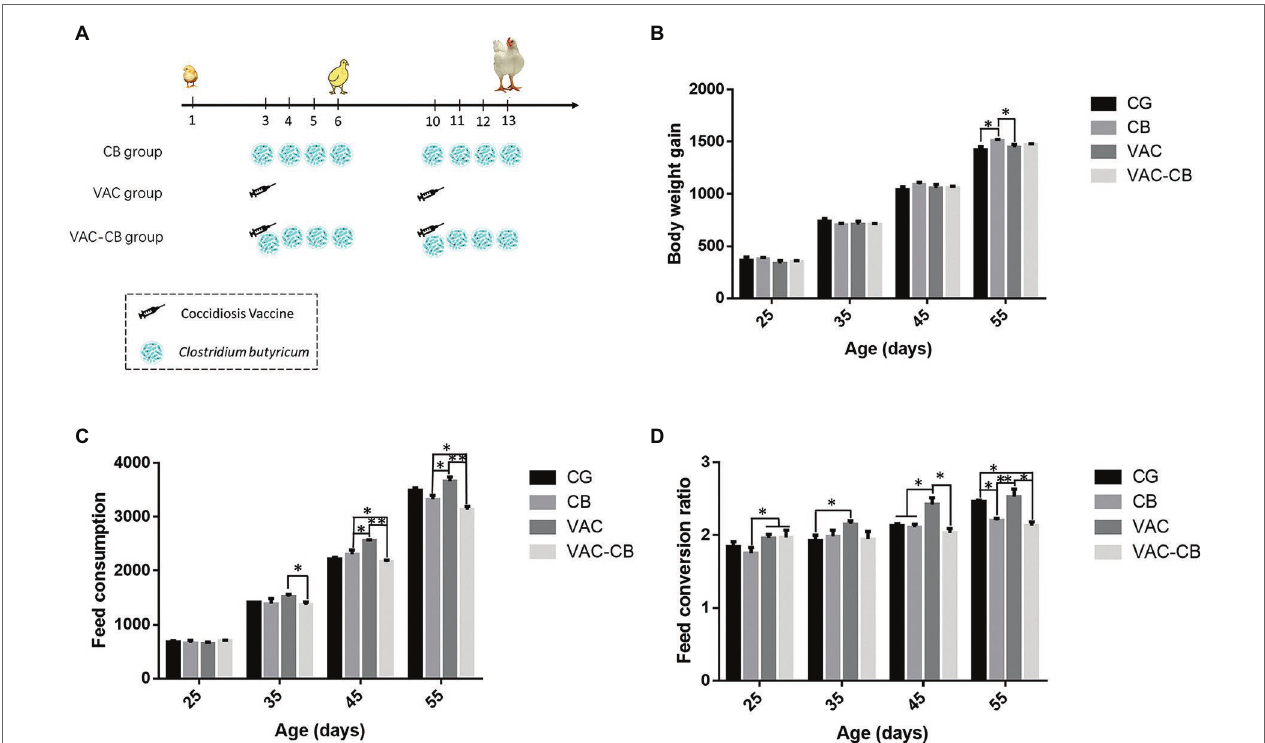
FIGURE 1 | Technical roadmap (A) and production performance of Mahuang broilers administered Clostridium butyricum and coccidiosis vaccine. The production performance results include body weight gain (B) , feed consumption (C) , and feed conversion ratio (D) . The four experimental groups included control (CG), C. butyricum pretreatment (CB), coccidial vaccine pretreatment (VAC) and coccidial vaccine and C. butyricum co-pretreatment (VAC-CB) groups. Significant differences between groups are shown by asterisks: * p < 0.05; ** p <